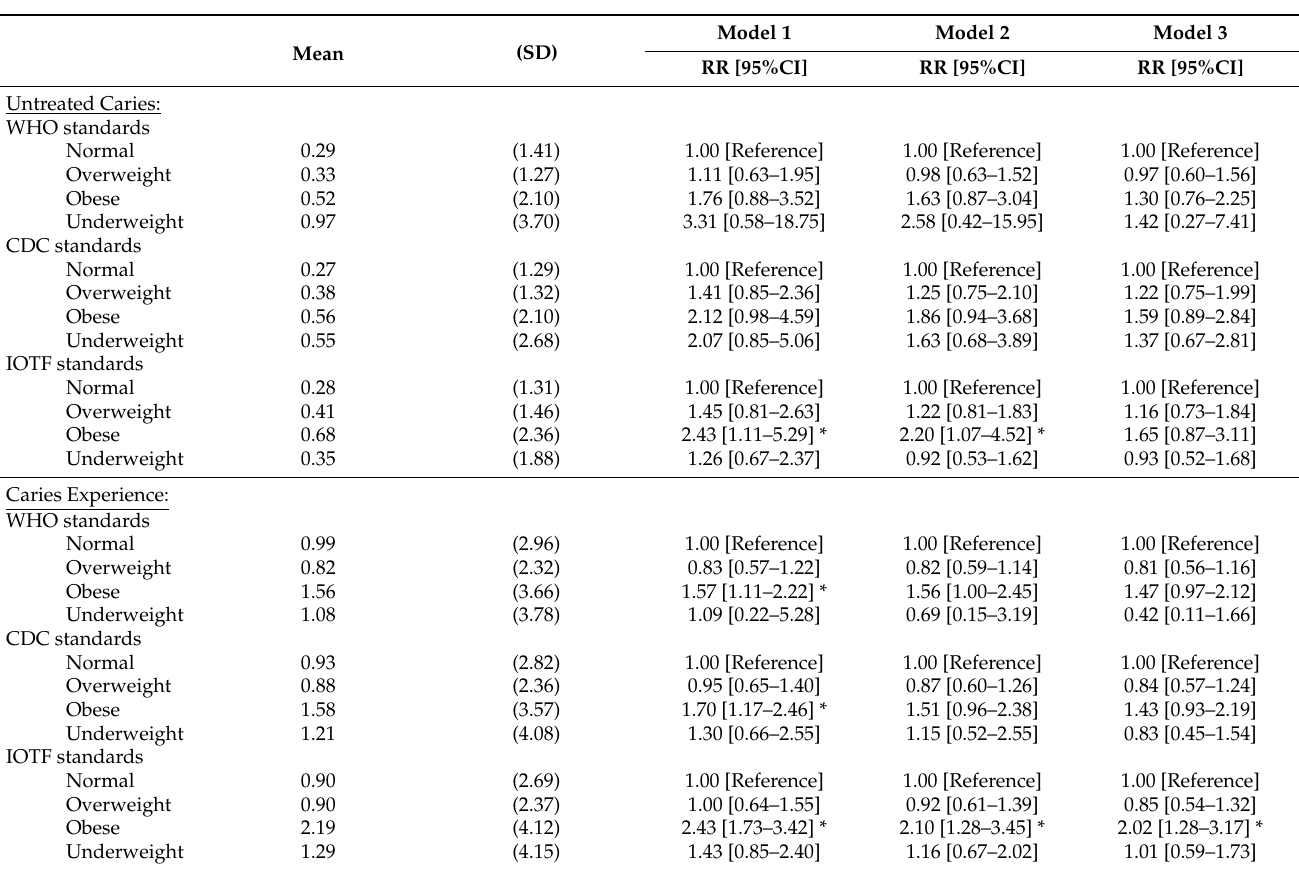
Table 3. Models for the association of BMI groups (as defined by three international standards) with dt and dft scores among 2–5-year-old children ( n =